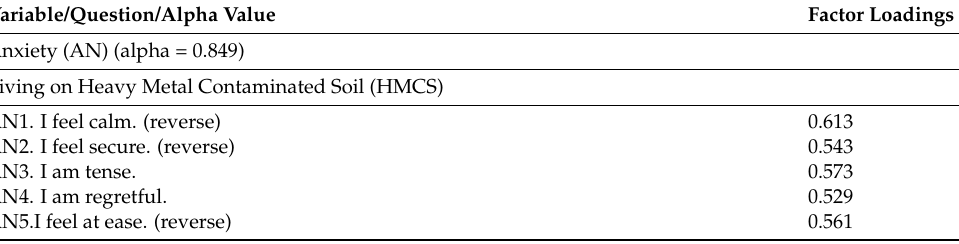
Table A1. Items to measure anxiety, optimism, pessimism, perceived risk, social trust, and